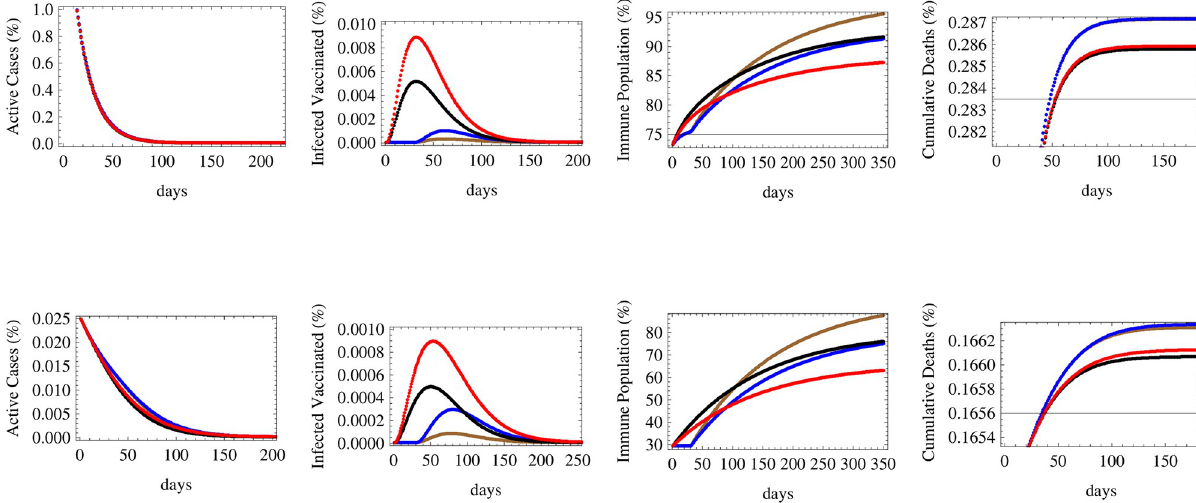
Fig 7. The figure shows the expected relative numbers of active cases, infected vaccinated cases, immune population and cumulative deaths corresponding to a medium reproductive rate R = 1.1 with same initial conditions, efficacies and time of initiation as those detailed in Fig 6.